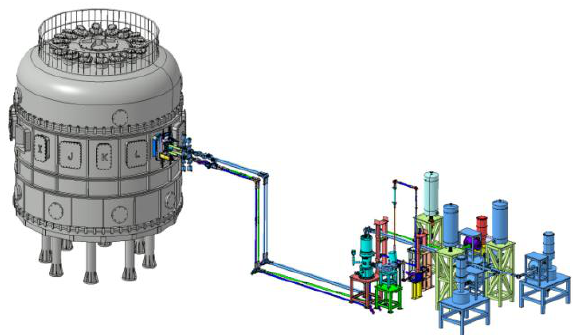
Fig. 1. Schematic of 140GHz/ 4MW long pulse ECRH system on